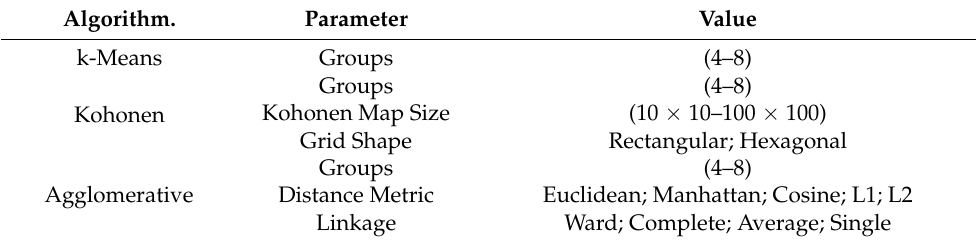
Table 1. Parameters of clustering algorithms.